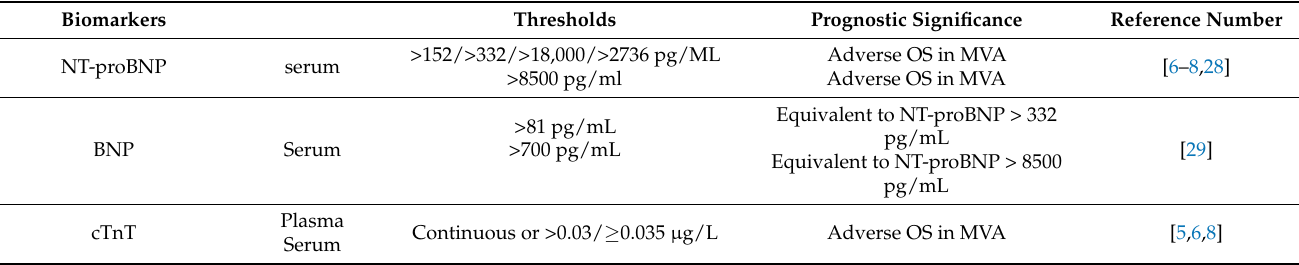
Table 2. Prognostic significance of organ-function related biomarkers in AL amyloidosis. NT-proBNP, amino-terminal portion of pro-brain natriuretic peptide type B; MVA, multivariate analysis; UVA, univariate analysis; OS, overall survival; EFS, event-free survival; RS, renal survival; BNP, natriuretic peptide type B; cTnT, cardiac troponin T; cTnI, cardiac troponin I; hs-cTnT, high-sensitivity cardiac troponin; LV, left ventricle; NYHA, New York Heart Association; echo, echocardiogram; ECF, electrocardiogram; MRI, cardiac magnetic resonance tomography; LVEF, left ventricular ejection fraction; GLS, global longitudinal strain; eGFR, estimated glomerular filtration